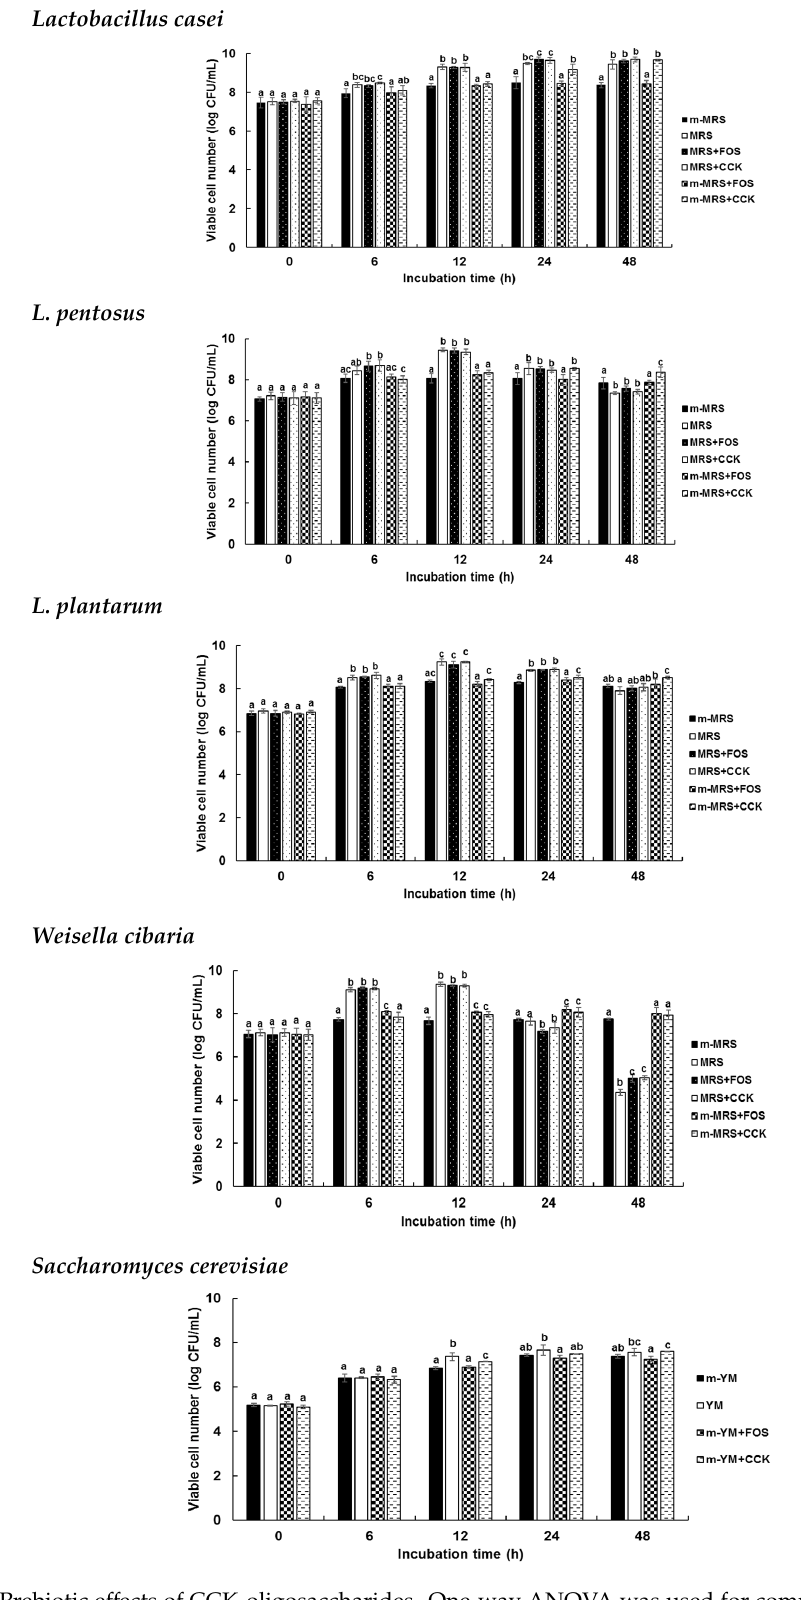
Figure 5. Prebiotic e ff ects of CCK-oligosaccharides. One-way ANOVA was used for comparison of group mean values, followed by Duncan’s multiple range test for significance of individual comparisons ( p < 0.05). Di ff erent alphabet letters among groups represent statistically significant di ff